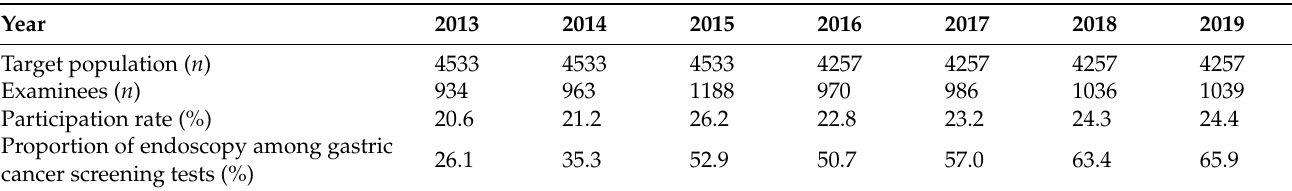
Table 2. Annual trends in the rate of participation for population-based gastric cancer screening in Hoki-cho, Tottori